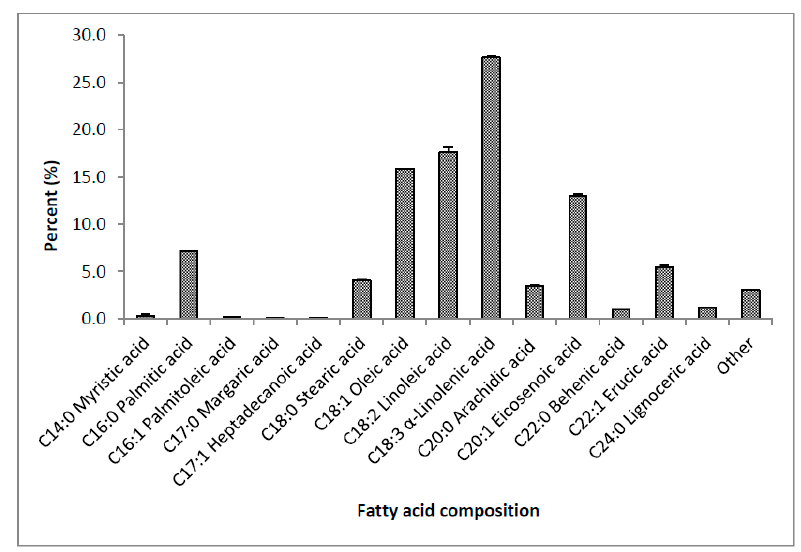
Figure 5. Fatty acid composition (wt. % of extracted oil) of camelina seeds. Data are expressed as mean ( n = 2) ± standard deviation.